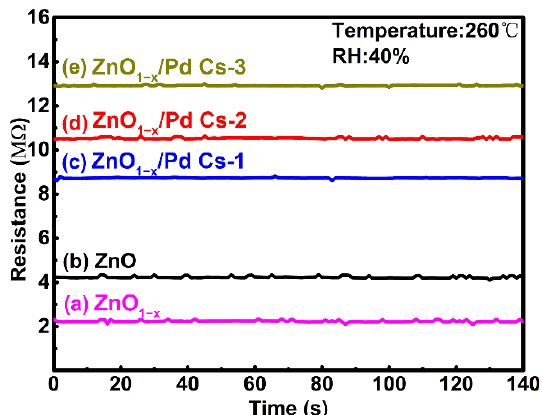
Figure 13. Base resistance in the air of the obtained sensors at 260 °C, 40% RH.